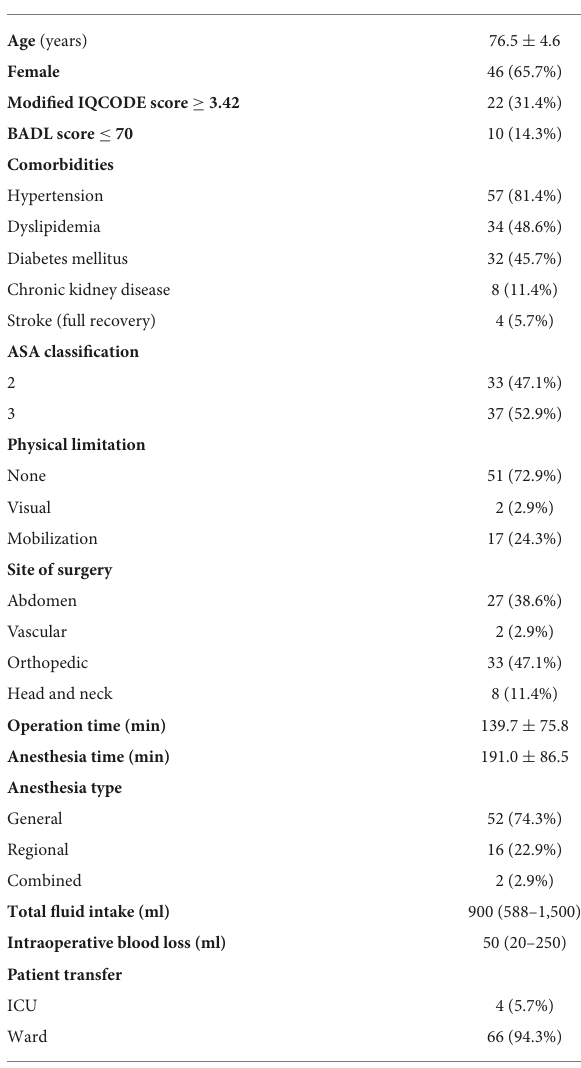
TABLE 1 Demographic characteristics of the